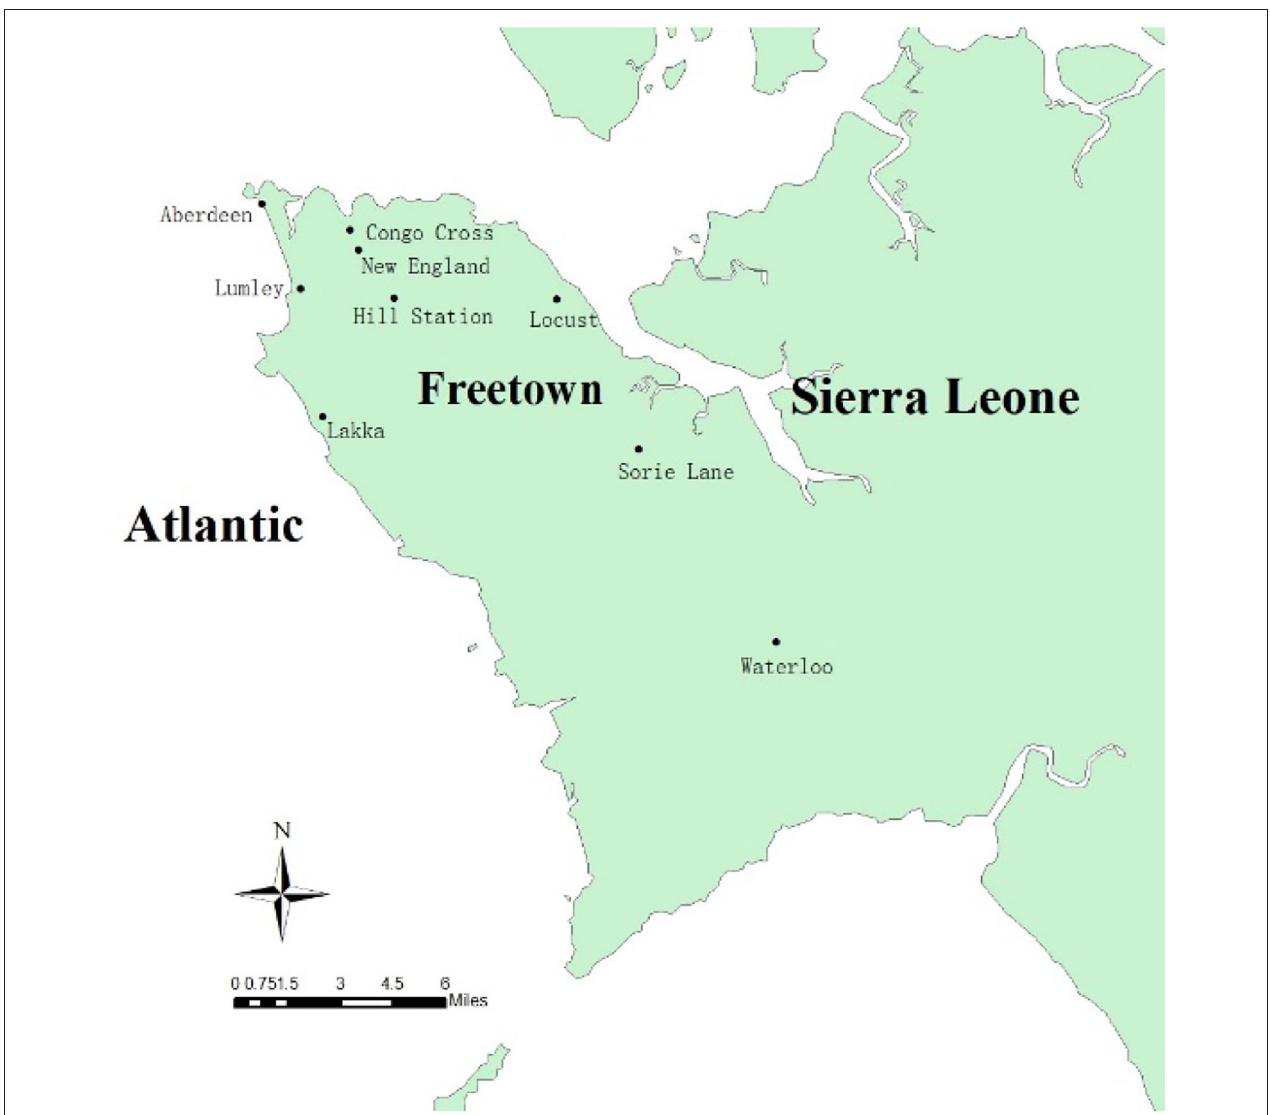
FIGURE 1 | Distribution of mosquito surveillance sites in Freetown, Sierra Leone.